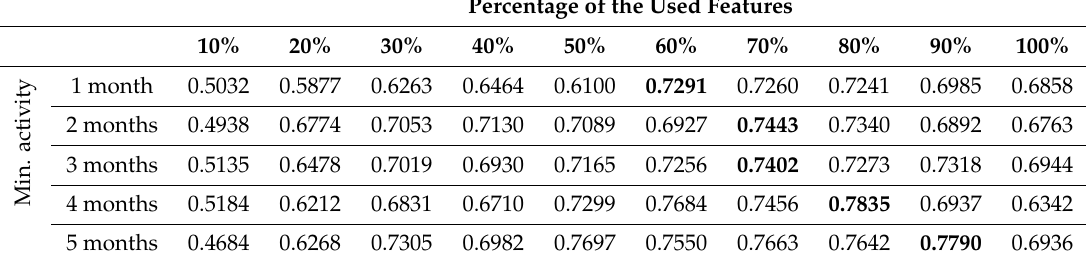
Table A13. F-score macro average for the Neural Network classification of two levels of the hierarchy in the Enron dataset. The values which are bolded are the best results for a given minimum communication activity.